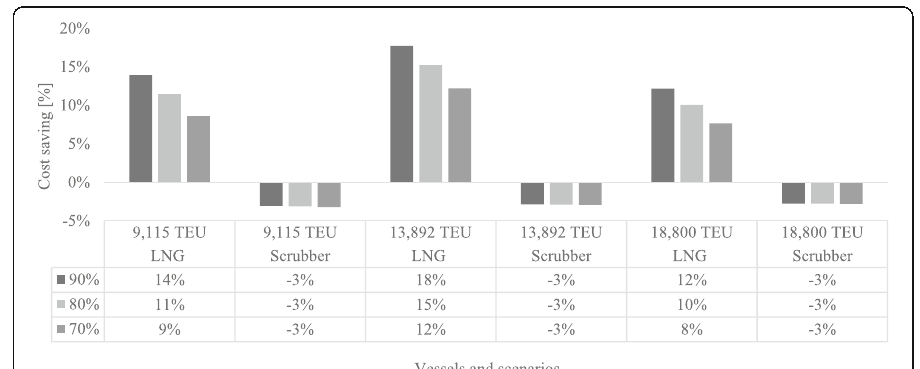
Fig. 3 Relative changes for the maritime cost (vessel owner ’ s cost) from Asia to EU for different ship types and for LNG and scrubber scenarios